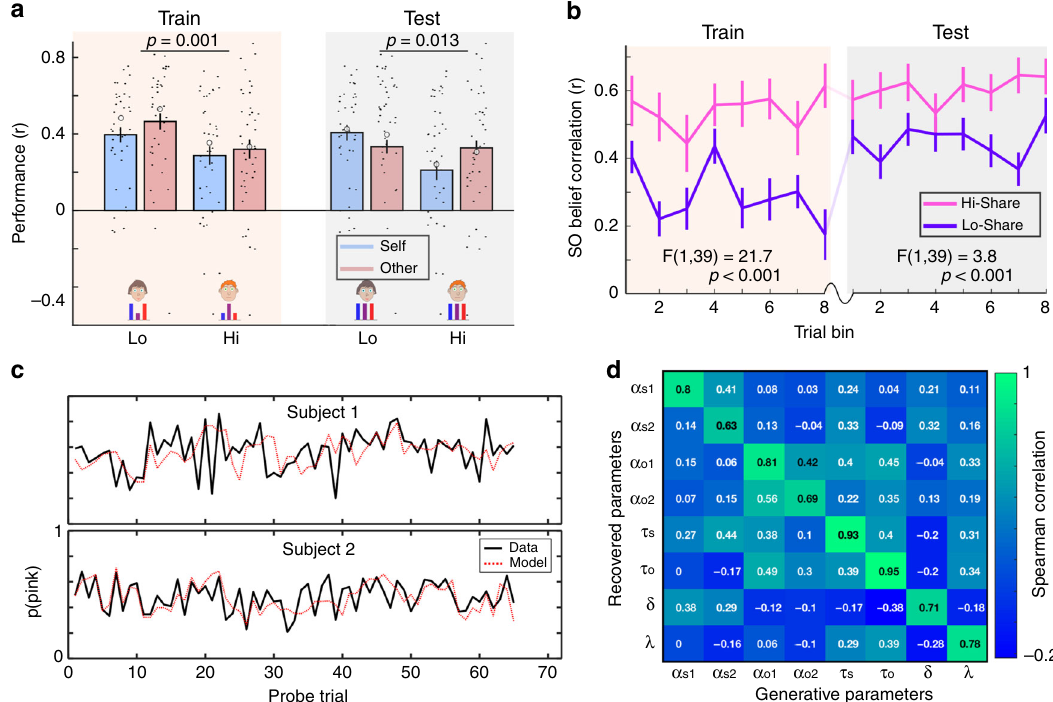
Fig. 2 Behavioural training induces sustained changes in Self-Other distinction ability. a Performance in FBT, split by session (train or test), context (Lo- Share or Hi-Share) and probe trial (Self or Other). In both sessions, there was a main effect of context with worse performance in the Hi-Share context. Large white circles show the behaviour predicted by the winning models. n = 40 independent subjects. Repeated measures ANOVA testing for main effect of condition in training session F(1, 39) = 12.64, p = 0.001. Repeated measures ANOVA testing for main effect of condition in testing session F(1, 39) = 6.78, p = 0.013. b Correlation between model-derived Self- and Other-attributed beliefs in different trial bins, split by session and context. In both sessions, there was a main effect of context with a higher Self-Other correlation in the Hi-Share context (pink line) than in the Lo-Share context (purple line). This fi nding was invariant to the number of trial bins used in the analysis (see Supplementary Fig. 5) and was driven largely by the λ parameter (Supplementary Figs. 2 and 3). Repeated measures ANOVA testing for main effect of condition in training session F(1, 39) = 21.7, p < 0.001. Repeated measures ANOVA testing for main effect of condition in testing session F(1, 39) = 3.8, p < 0.001. c Generative performance of the best- fi tting model for the Hi-Share context in the test session for two exemplar subjects. Self and Other probe trials are intermixed in the order they were presented to the subjects. d Parameter identi fi ability of the most complex winning model (Hi-Share context test session). Each cell shows a Spearman correlation coef fi cient derived from correlating subjects ’ true parameter estimates with recovered parameter estimates. A subscript ‘ s ’ indicates that the parameter is speci fi c to Self updates. A subscript ‘ o ’ indicates that the parameter is speci fi c to Other updates. A subscript ‘ 1 ’ indicates that the learning rate is speci fi c to ‘ privileged ’ and ‘ decoy